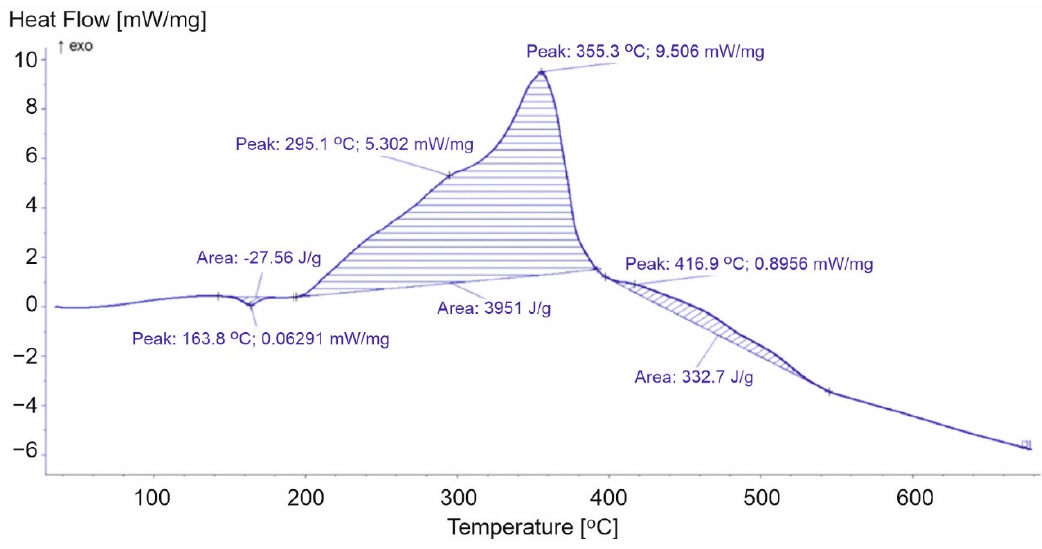
Figure 7. DSC curve for PP-3. Table 2. Selected parameters for the DSC analysis for polypropylene.